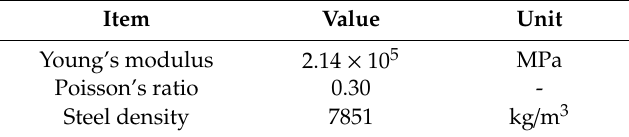
Table 1. Material properties of the electrical cabinet.